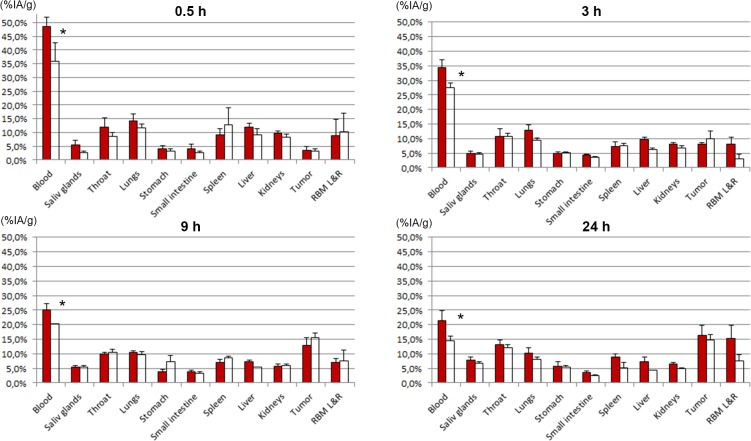
Tissue distributions of 211At-MX35 and 211At-Rebmab200.
211At-MX35 (filled bars) and 211At-Rebmab200 (open bars). Results are given as mean ± standard deviation of percent injected activity per gram tissue (%-IA/g). *P<0.05 by Student’s t-test. Abbreviation RBM L&R is the red bone marrow taken from left and right femur.